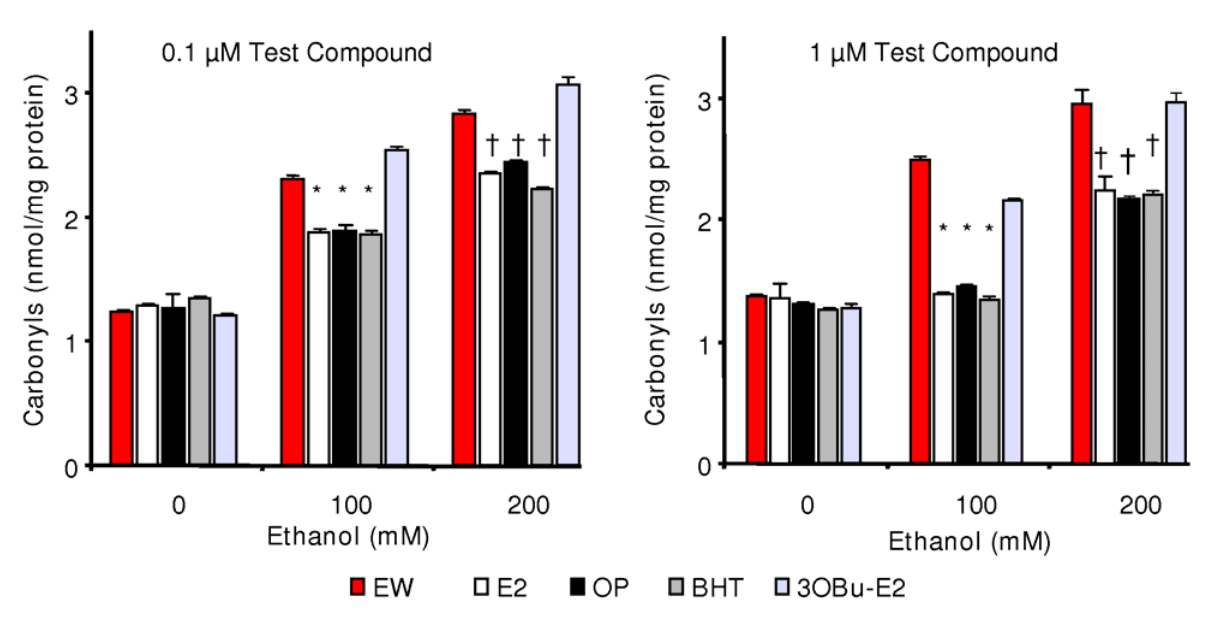
Figure 5. Effects of E2, OP, BHT and 3OBu-E2 on EW-induced protein carbonylation . Data are given as mean ± S.E.M. for n=4. *p<0.001 and † p<0.01 vs. corresponding